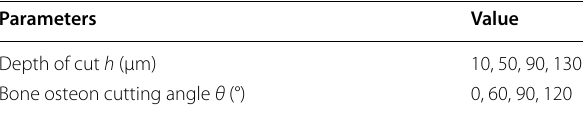
Table 1 The parameters of orthogonal cutting